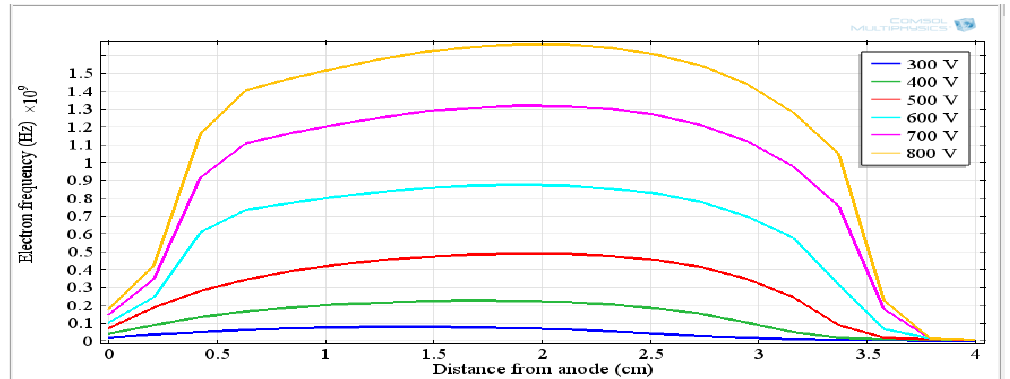
Fig. 7: Electron frequency as a function distance from anode at different discharge